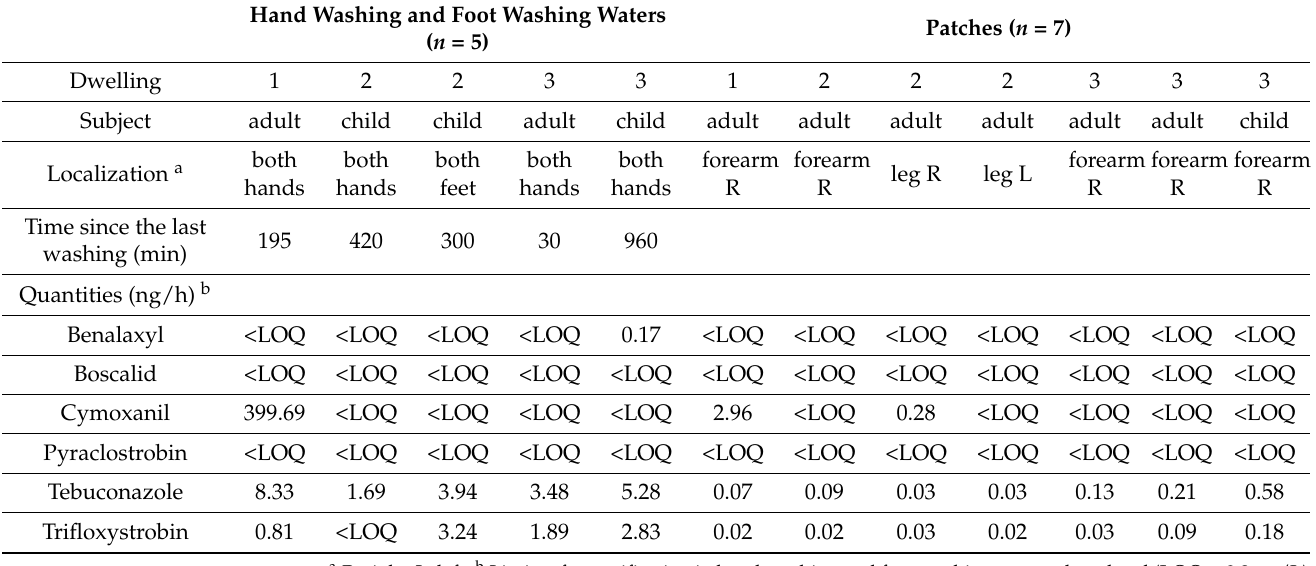
Table 4. External contamination of participants: pesticide amounts in hand washing and foot washing waters ( n = 5) and in patches ( n = 7).